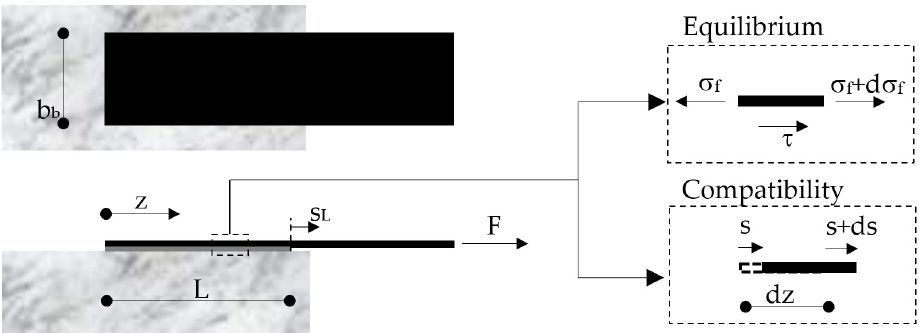
Figure 1. Single-lap shear test of an FRP-to-concrete bonded joint.